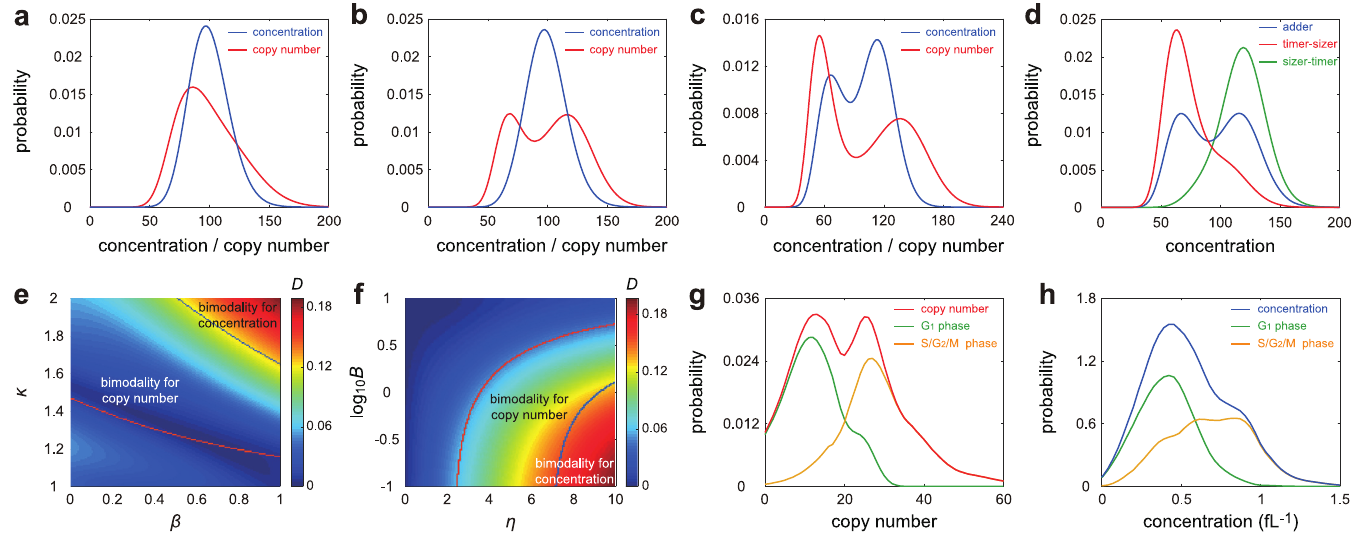
Fig 6. Influence of model parameters on copy number and concentration distributions. A-C : The copy number (red curve) and concentration (blue curve) distributions display different shapes under different choices of parameters. A Both distributions are unimodal. B The concentration distribution is unimodal while the copy number one is bimodal. C Both distributions are bimodal. D : Concentration distributions under three different size control strategies: adder (blue curve), timer- sizer (red curve), and sizer-timer (green curve). Two-layer control strategies lead to unimodal concentration distributions that are not far from gamma. E,F : Heat plot of the Hellinger distance D of the concentration distribution from its gamma approximation versus β (the degree of balanced biosynthesis), κ (the strength of dosage compensation), η (the stability of the gene product), and B (the mean burst size). The violet (blue) curve encloses the region for the copy number (concentration) distribution being bimodal. The bimodal region for the copy number distribution is much larger than that for the concentration distribution. G,H : The mRNA copy number (red curve) and concentration (blue curve) distributions for the HTB2 gene in budding yeast measured using smFISH. The green (yellow) curves show the distributions of cells in the G 1 (G 2 -S-M) phase. No apparent dosage compensation was observed with the mean copy number (concentration) in G 2 -S-M being 2.22 (1.66) times greater than that in G 1 . The data shown are published in [92]. See Section F in S1 Appendix for the technical details of this figure.